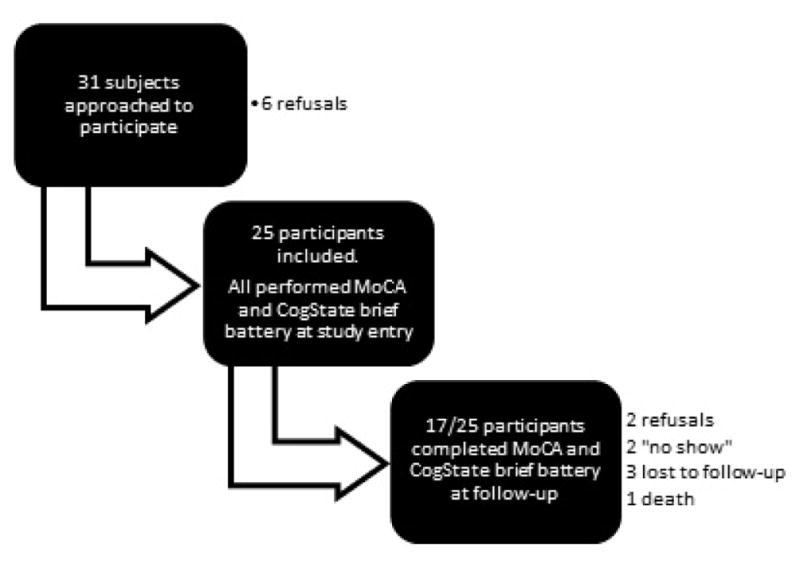
Study flowchart.